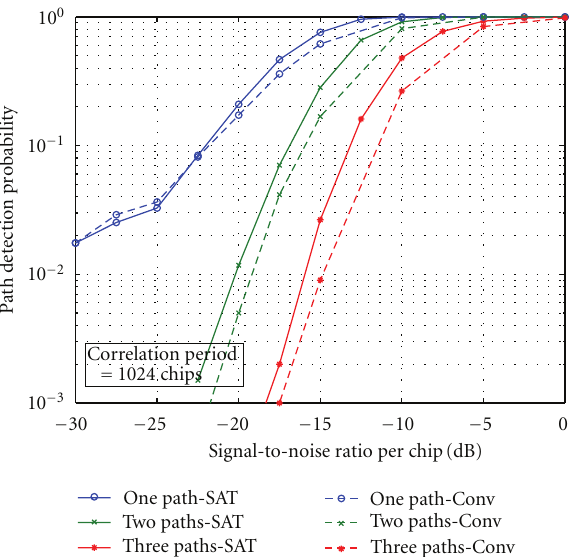
Figure 5: Probability of detection with 256 chips correlation.